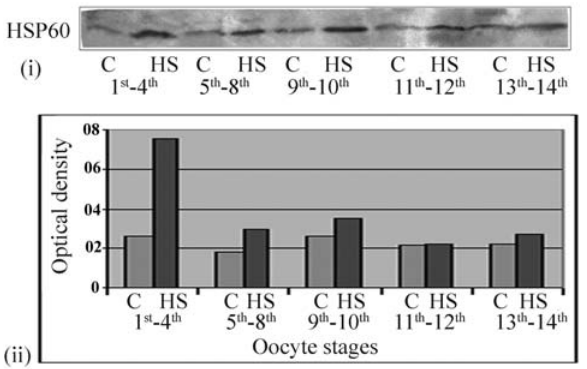
Figure 3B - (i). Western blot showing the HSP60 expression pattern dur- ing the 1 st -4 th , 5 th -8 th , 9 th -10 th , 11th-12 th and 13th-14th stages of oocyte de- velopment in M. domestica at the control (C, 25 °C) and heat shock (HS, 42 °C) temperatures . (ii) Histogram showing densitometric optical density (OD) measurement of band intensity in the corresponding western blot lanes shown in (i) above.